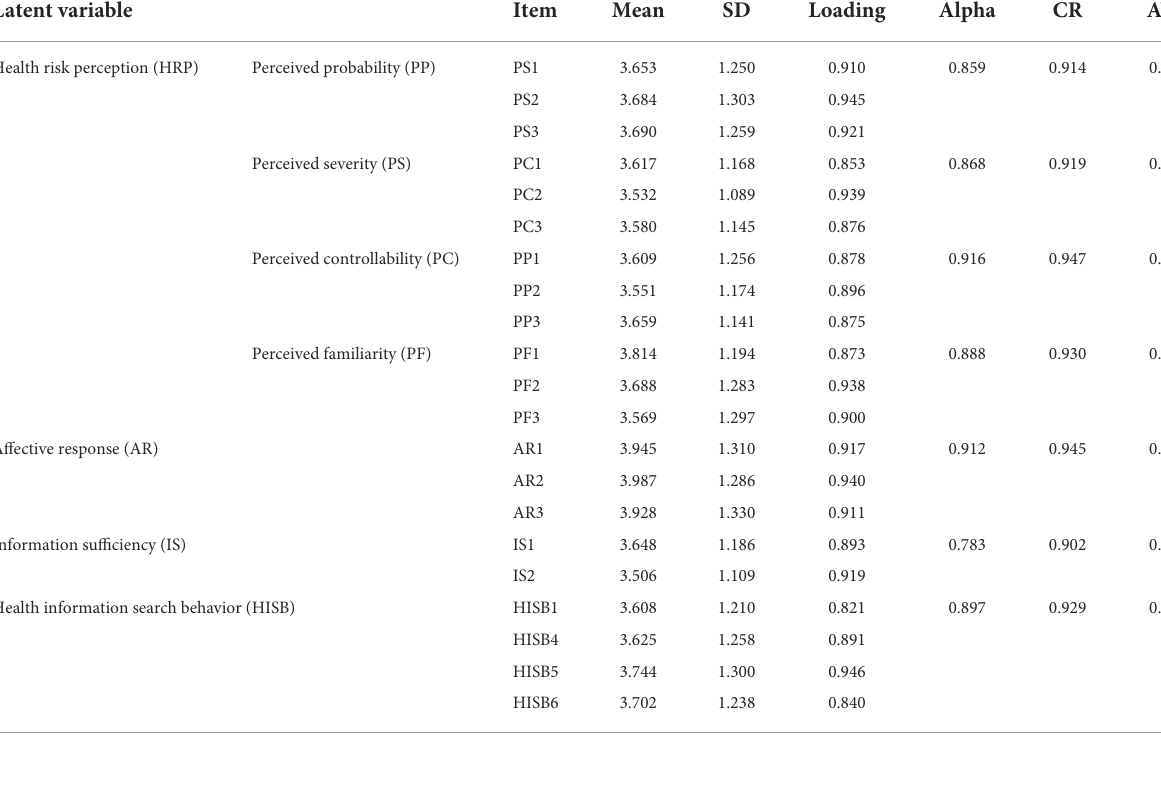
TABLE 6 Fornell-Larcker criterion.